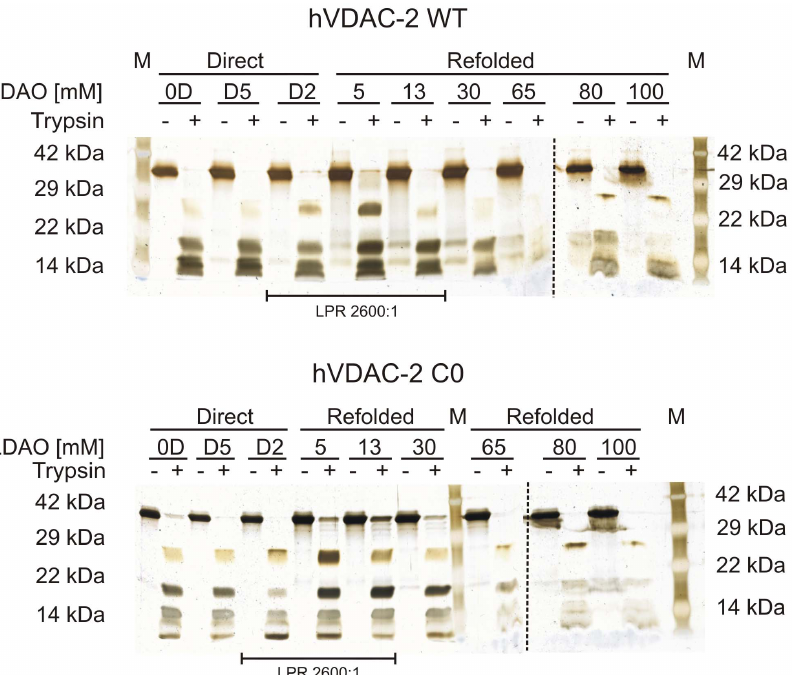
Figure 3. Monitoring the susceptibility of refolded hVDAC-2 to trypsinization with increasing LDAO. Representative silver stained SDS- PAGE gels of refolded WT (top) and C0 (bottom) subjected to a 10 min exposure to trypsin ( + ) and arrested by the addition of 5 mM PMSF are compared with undigested samples (–). The LDAO concentrations in each sample are indicated above each lane and the refolding method employed is also indicated (samples 0D, 2D and 5D are directly refolded and labeled ‘Direct’; those labeled ‘Refolded’ were generated by dilution of the refolded stock; see Materials and Methods for details of sample preparation). Note that D2, 5 and 13 samples possess a similar LPR of 2600:1. The observed distortion in protein migration, particularly in high LPR, is due to the presence of excess LDAO in the sample, which interferes in proper gel running. Relevant molecular weight standards (M) are indicated on either side of each gel. Dashed lines are used to separate different gels that are presented